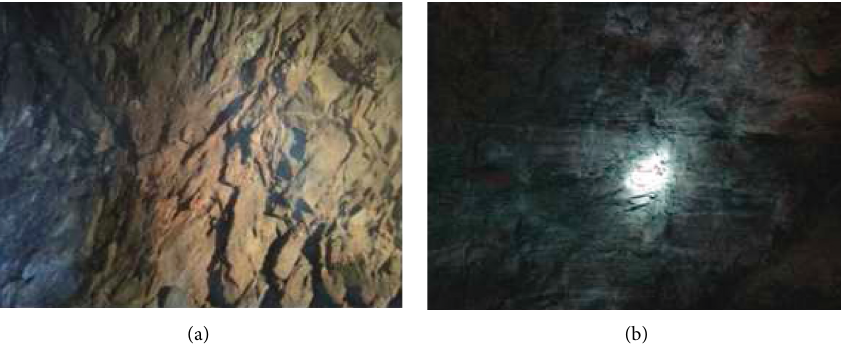
Figure 10: (a) The effect of conventional blasting technology. (b) The effect of ECHBT [61].